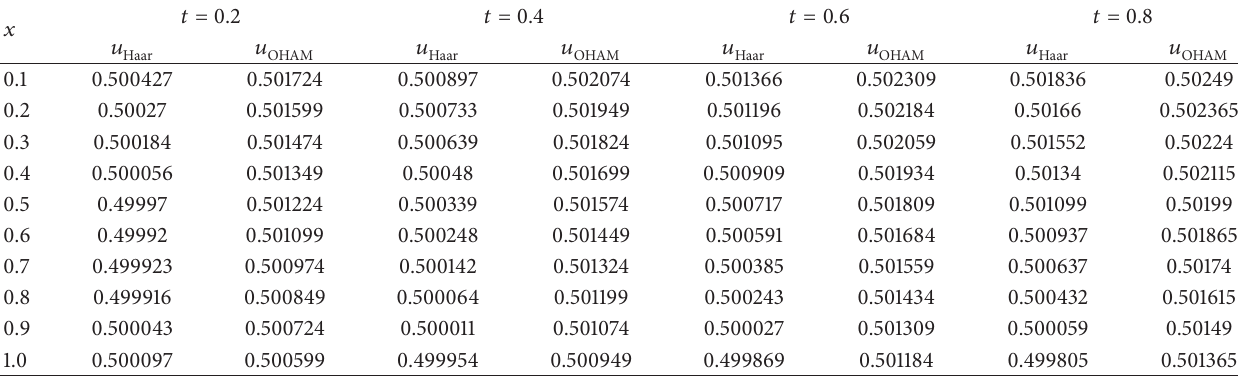
Table 5: The approximate solutions of fractional order Burgers-Fisher equation (35) using Haar wavelet method and three terms for second- order OHAM with convergence control parameters 𝐶 1 = −0.00019986 and 𝐶 2 = −0.999602 at various points of 𝑥 and 𝑡 for 𝛼 = 0.25 .